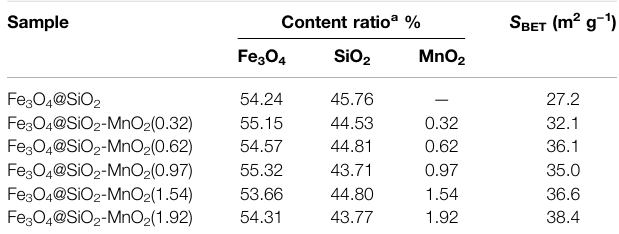
TABLE 1 | BET surface areas and contents of Fe 3 O 4 , SiO 2 and MnO 2 of the sorbents. Sample